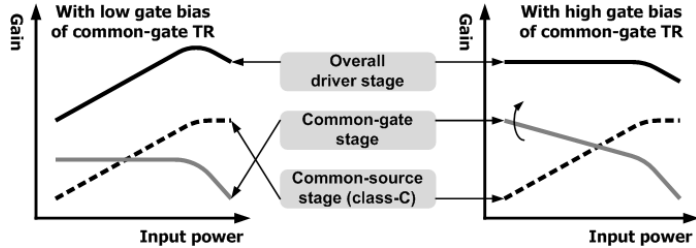
Figure 5. Conceptual gain of driver stage composed of the cascode structure.